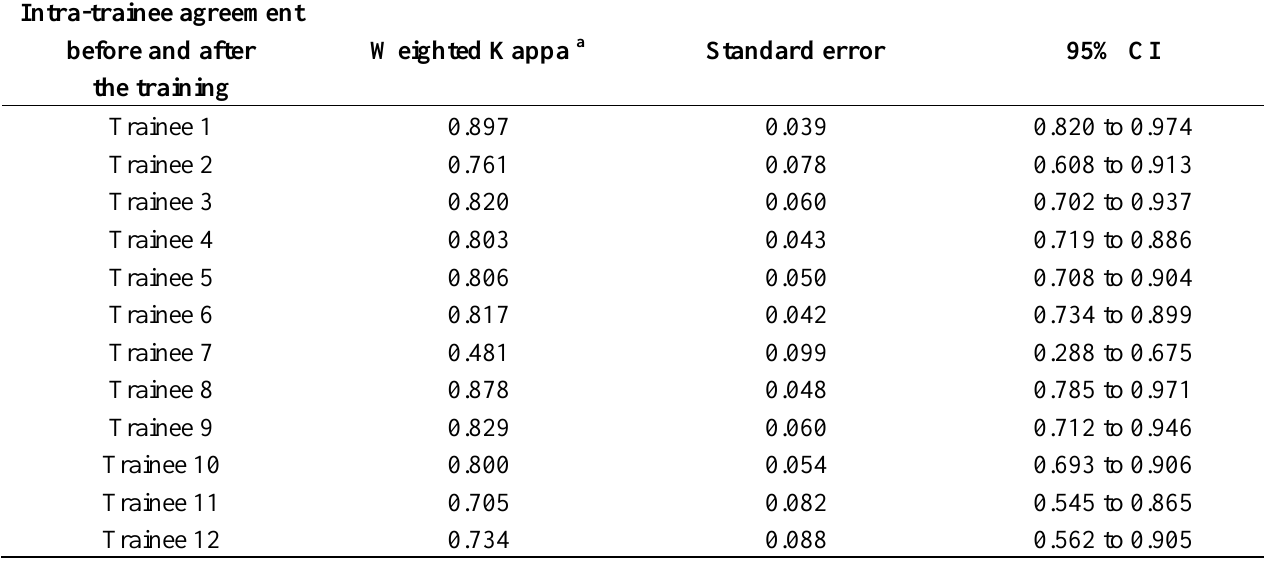
Table 1. The intra-examiner weighted kappa